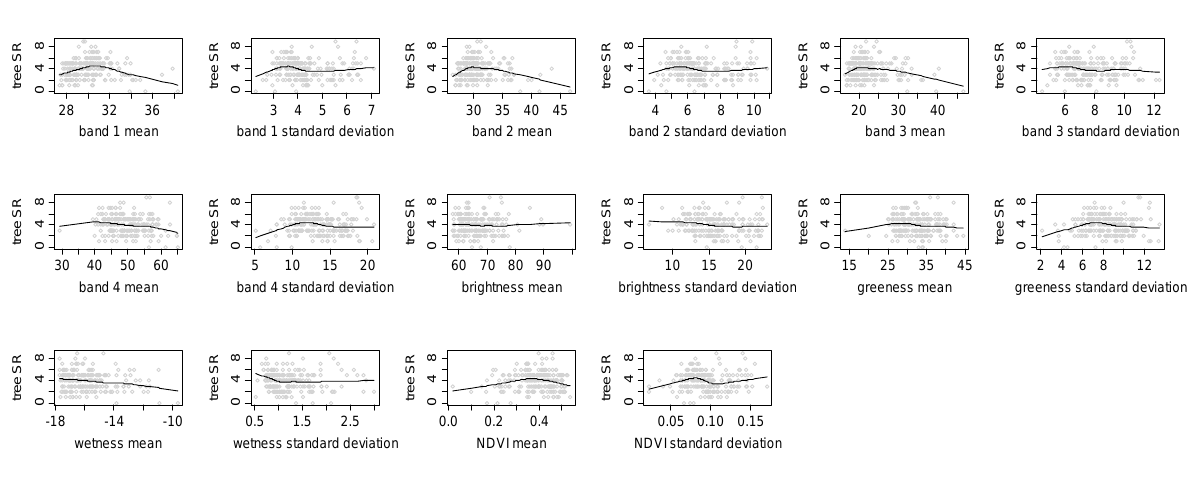
Figure 7. Scatterplots of tree species richness (SR) vs. IKONOS spectral variables. Fitted curves represent LOWESS based smoothing.